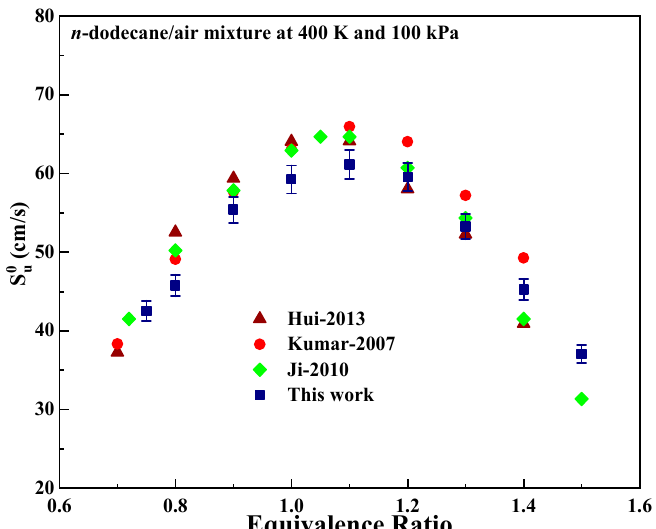
Figure 3. Comparisons of S 0 u of n-dodecane obtained from prior experimental trials and from the present work.